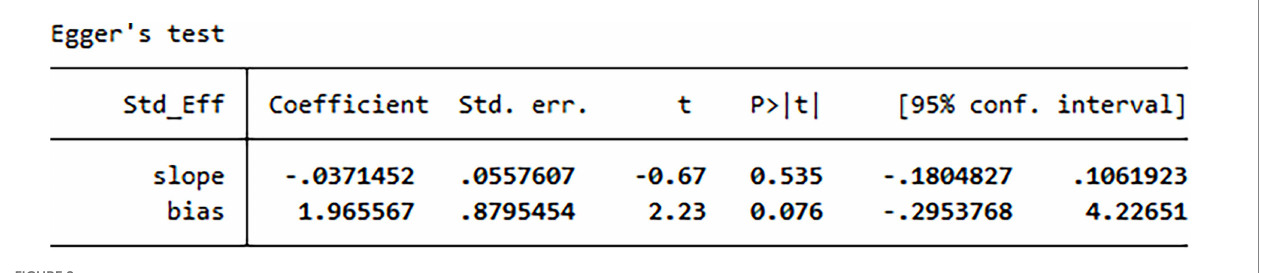
FIGURE 8 Egger’s test of publication